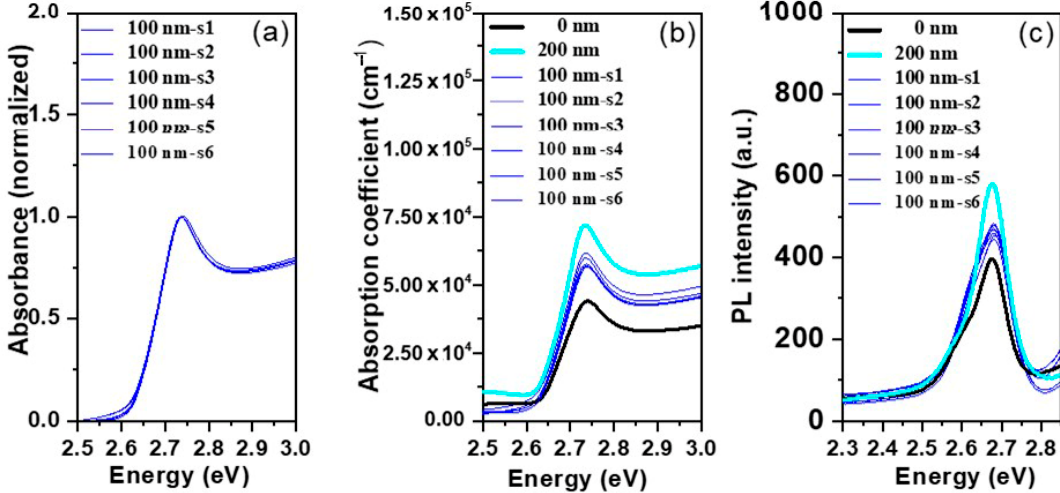
Figure 11. ( a ) Optical absorption spectra; ( b ) absorption coefficient spectra; ( c ) emission spectra of six samples (CsPb(Br 0.5 Cl 0.5 ) 3 perovskite thin films) encapclated by PMMA film, t = 100 nm, compared to samples with a thickness of PMMA layer (t = 0 and 200 nm).